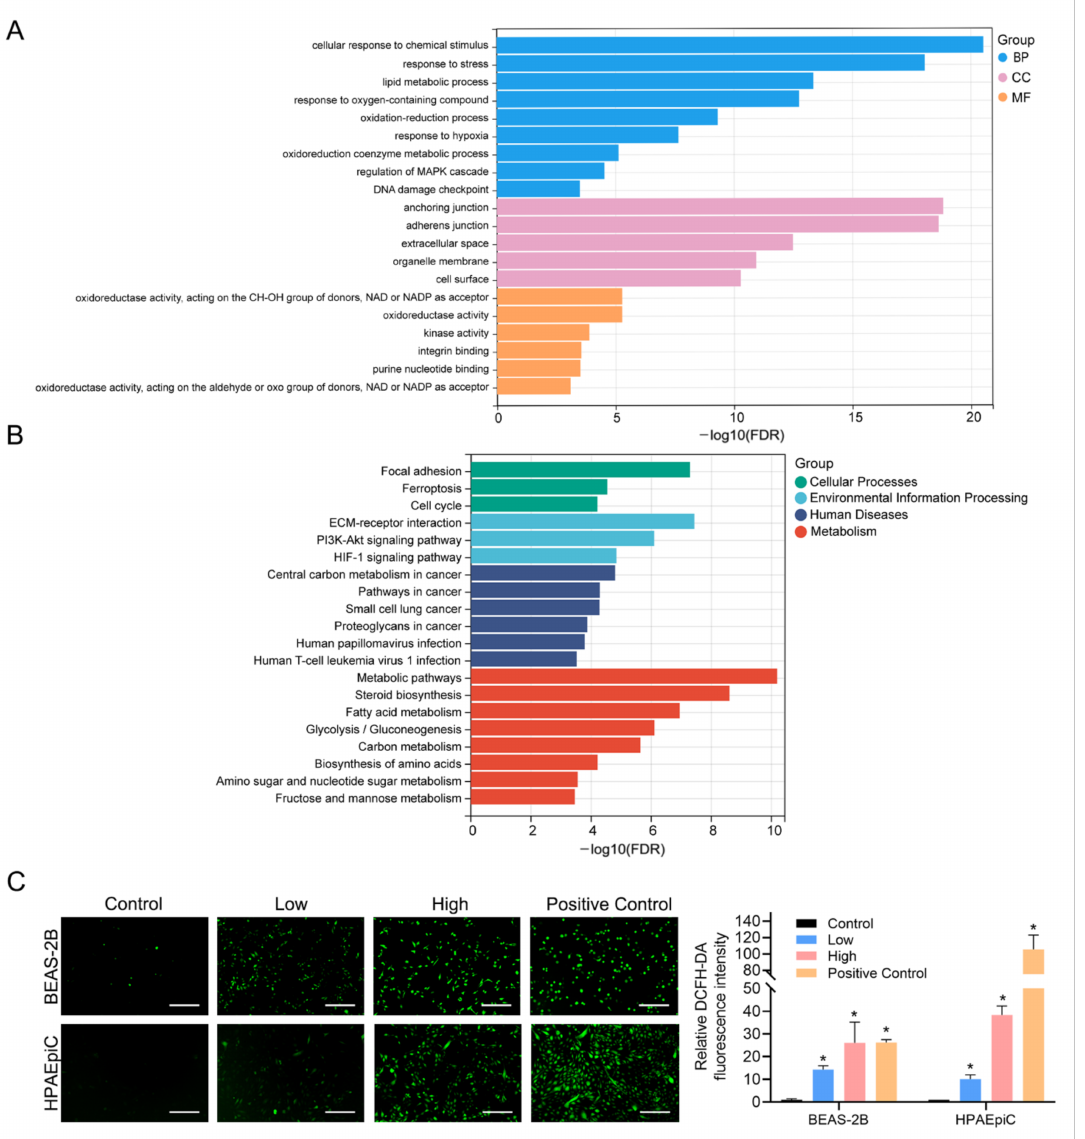
Figure 3. Functional annotation of DEGs induced by PS-NPs and validation of ROS. ( A , B ): DEGs with consistent trend in two concentrations of PS-NP-treated groups were selected for GO analysis ( A ) and KEGG pathway analysis ( B ). ( C ) The levels of ROS were detected by DCFH-DA staining assays. Scale bars: 200 µ m. ”BP” denotes “Biological Process”, ”CC” denotes “Cell Component” and “MP” denotes “Molecular Function”. * p -value < 0.05 indicates statistically significant differences from the